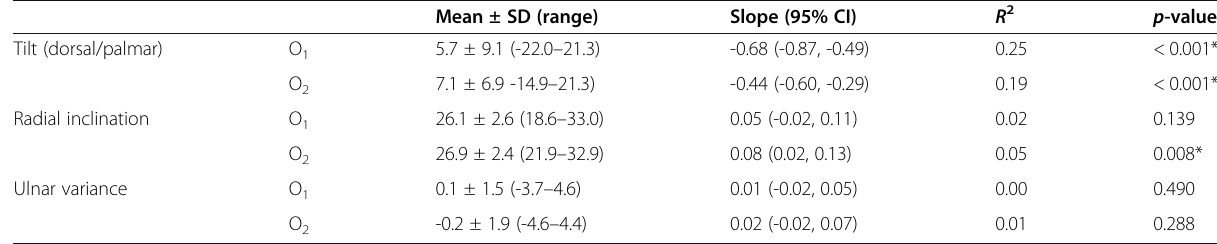
Table 2 Mean measured values and results of univariate linear regression analyses for the impact of rotation on tilt, radial inclination, and ulnar variance using RSA values of rotation ( n = 147)